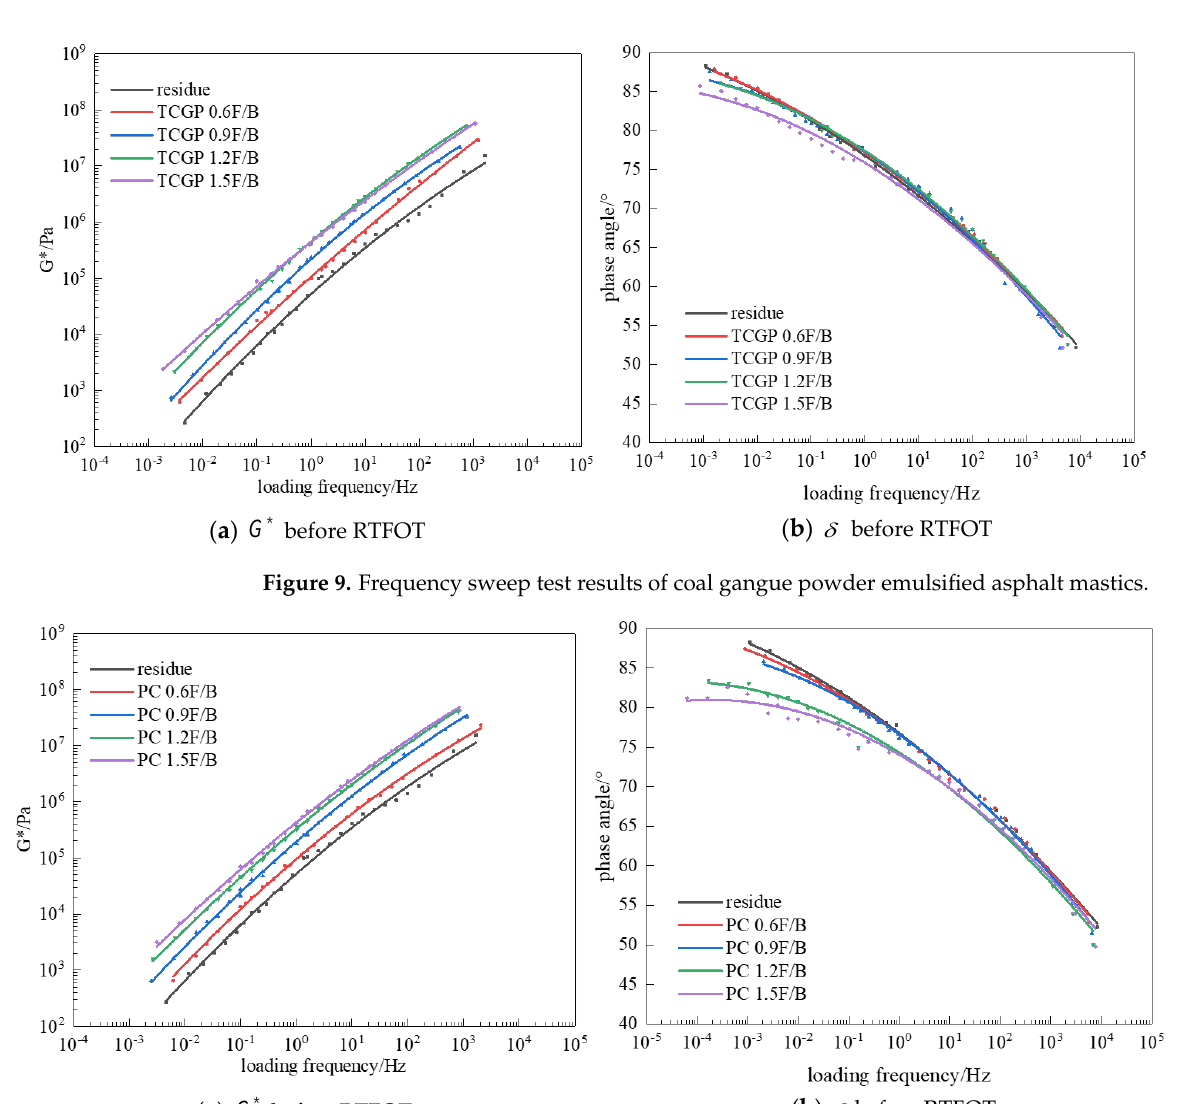
Figure 8. Frequency sweep test results of limestone powder emulsified asphalt mastics.